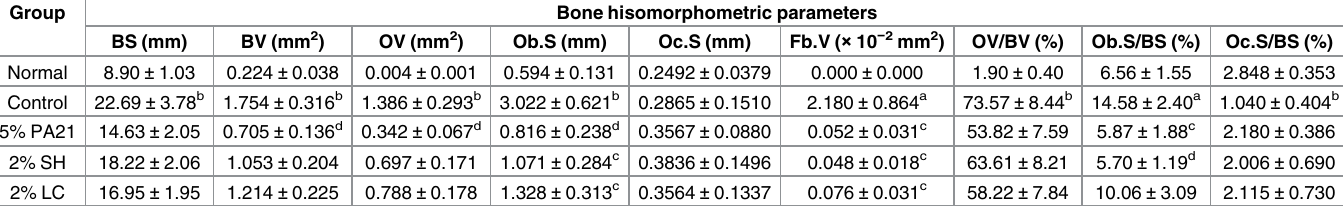
Table 4. Effects of PA21, sevelamer hydrochloride, and lanthanum carbonate hydrate on trabecular bone histomorphometric parameters. Group